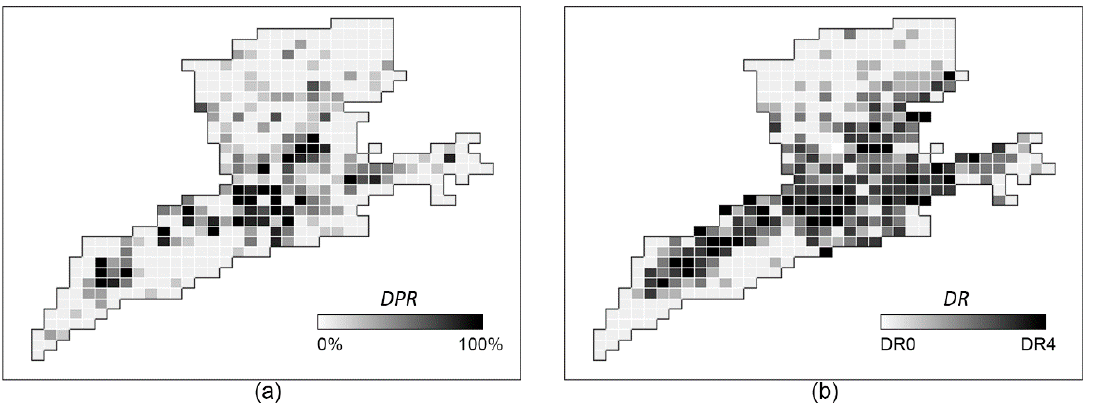
Figure 14. ( a ) Damaged pixel rate (DPR) by synthetic aperture radar (SAR) data and ( b ) major damage rate (DR) by the field survey.